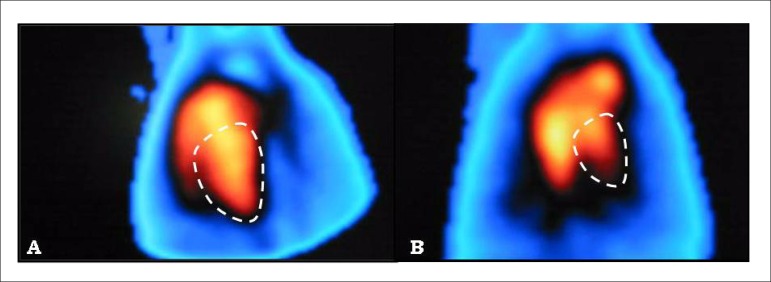
Images of the cardiac blood compartment labeled with 99mTc
in the left anterior oblique projection, in diastolic (A) and
systolic (B) frames, allowing quantification of the LVSF after
regions of interest were traced. LVSF = 76%.